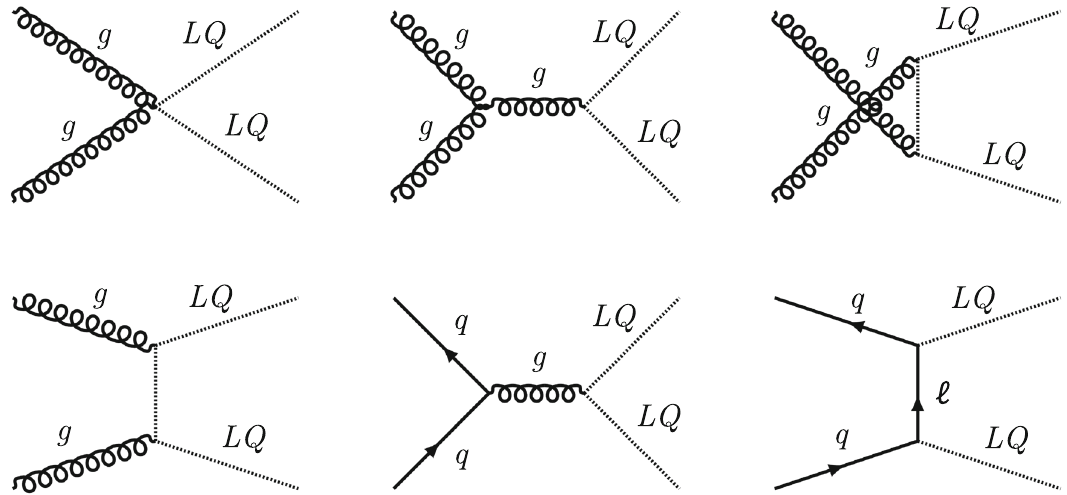
Fig. 1 The lowest-order Feynman diagrams for LQ pair production. In this paper, the t-channel lepton exchange diagram is ignored